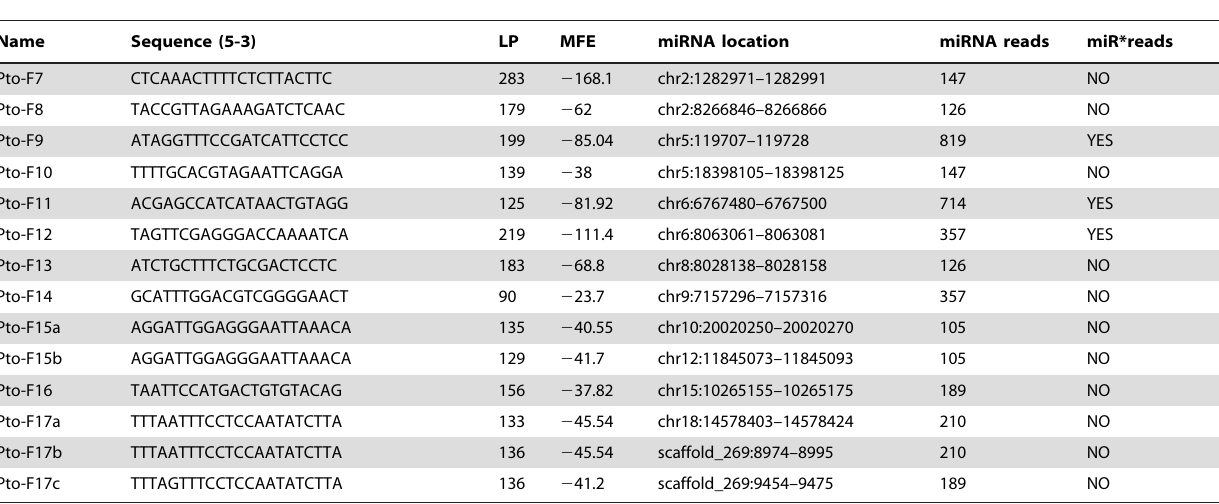
Table 4. Summary of male-specific novel